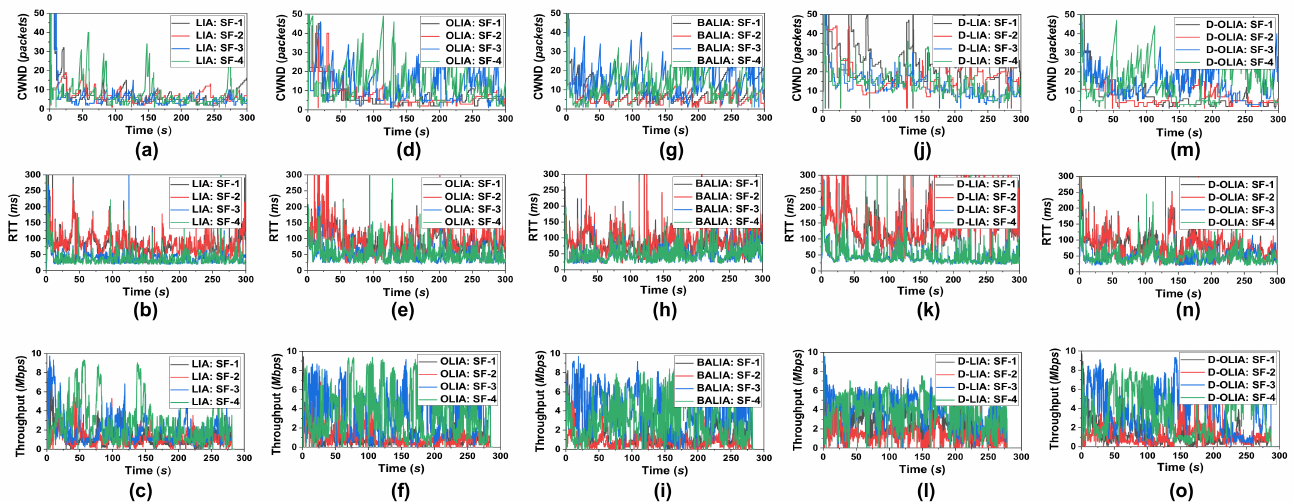
Figure 8. Performance of the considered MPTCP-CCAs for Scenario #3 in terms of CWND, RTT, and throughput for ( a – c ) LIA, ( d – f ) OLIA, ( g – i ) BALIA, ( j – l ) D-LIA, and ( m – o ) D-OLIA.